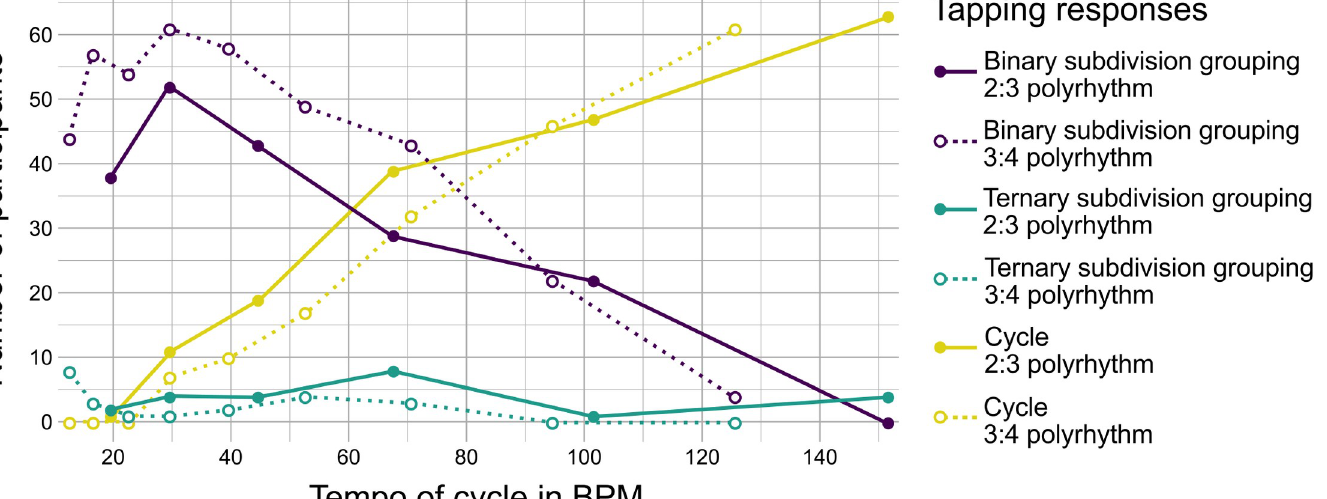
PLOS ONE | https://doi.org/10.1371/journal.pone.0252174 August 20,